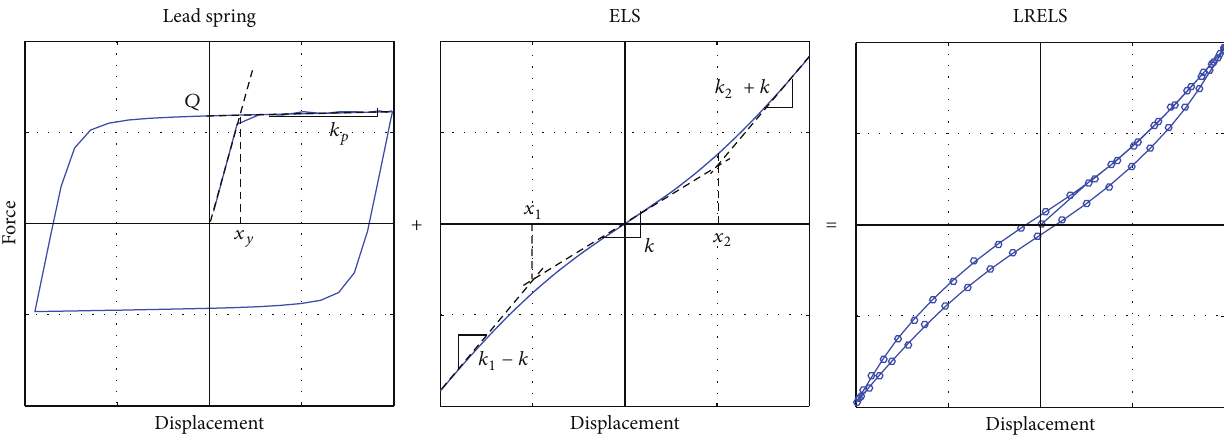
Figure 7: Out-of-plane behavior: force (LRELS) = force (ELS) + force (lead spring).